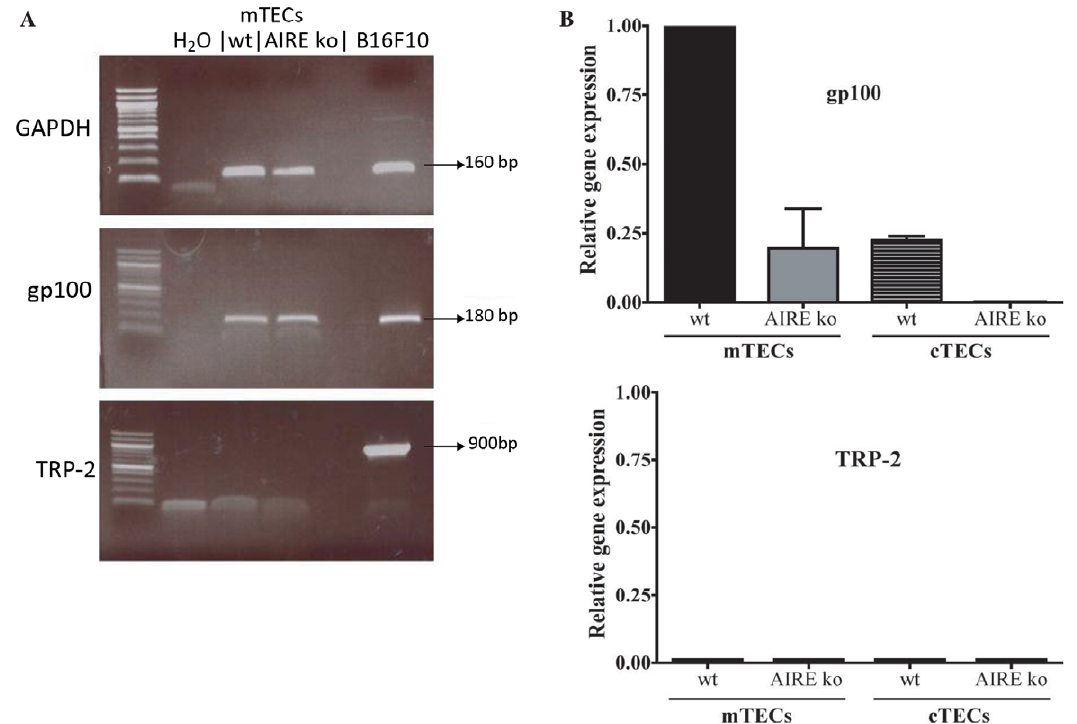
Figure 8. Expression of melanocyte antigens in medullary thymic epithelial cells. Medullary or cortical thymic epithelial cells were sorted by flow cytometry. A RT-PCR was performed on both types of cells using primers for GAPDH, gp100 and TRP-2. B Real time qPCR was performed using sorted populations. Expression relative to gp100 expression in AIRE + / + mTECs is shown for gp100 and TRP-2. Error bars are from duplicates.